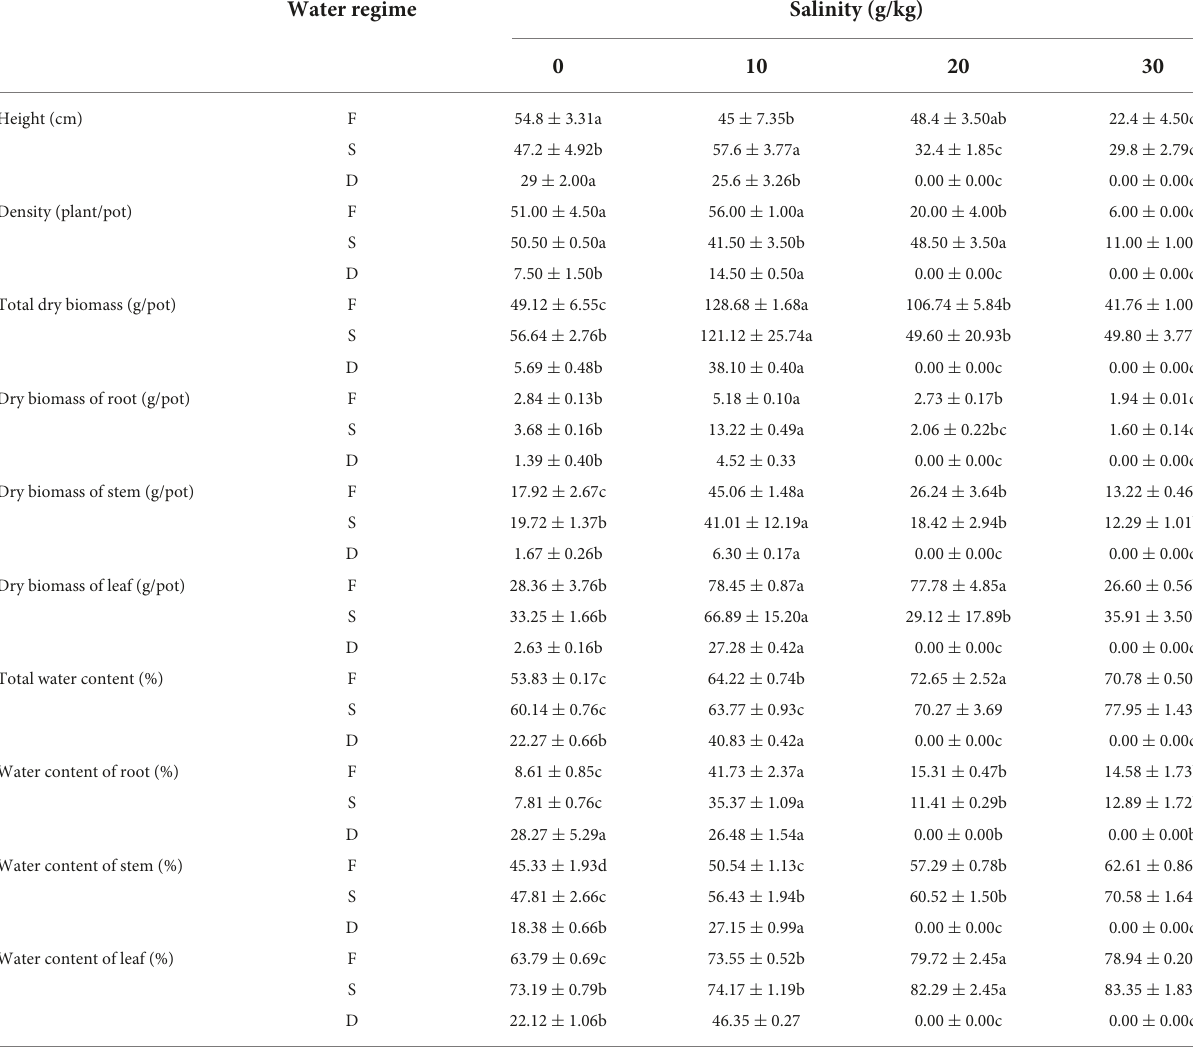
TABLE 2 Growth characteristics of S. salsa subjected to water [long-term flooding (5–15 cm, F), periodic flooding (0–10 cm, S), and long-term drought (drought to saturated, D)] and salt treatments. Water